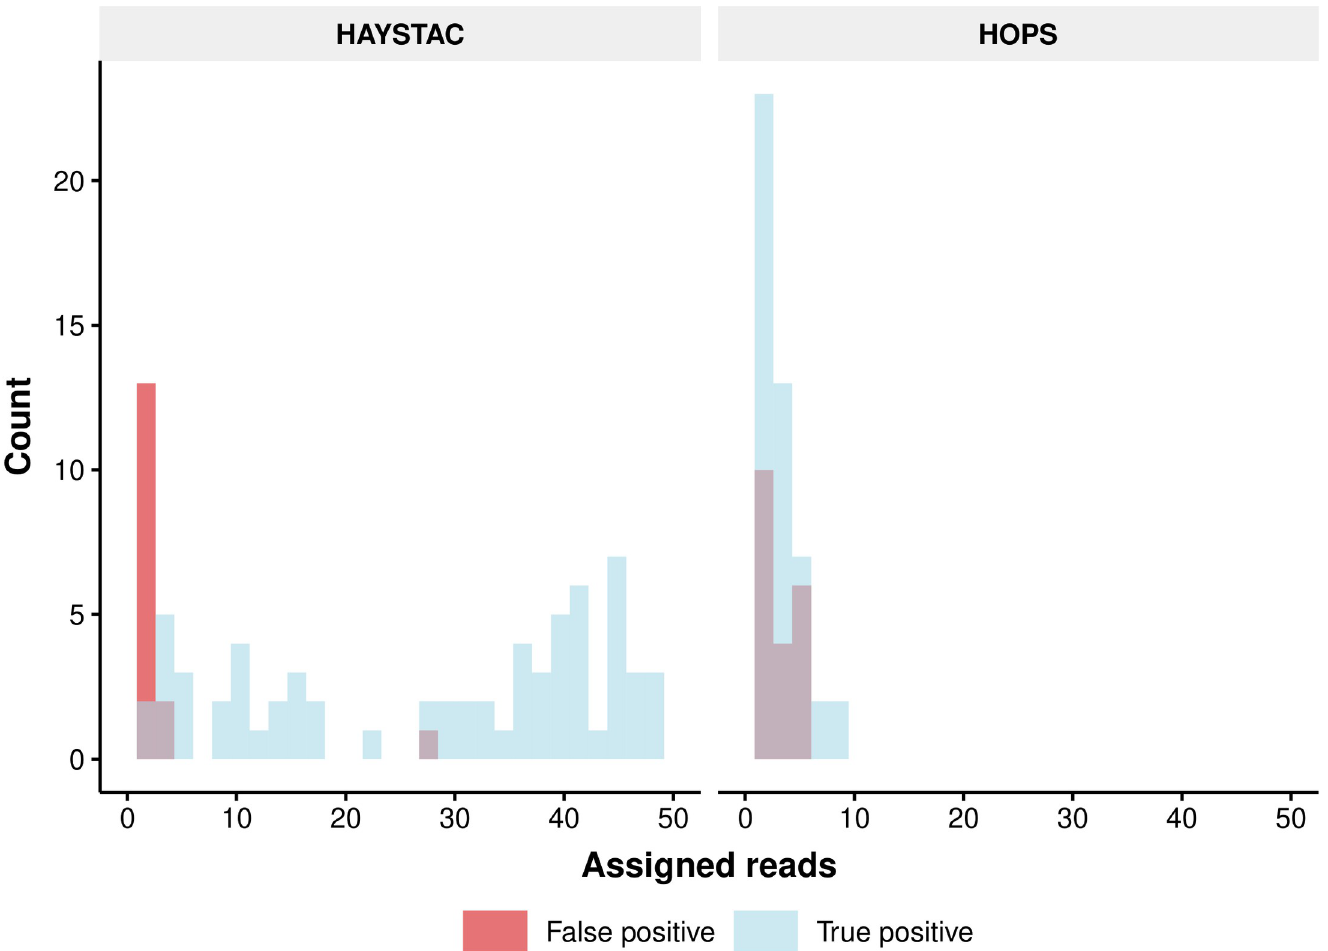
Fig 7. Histogram of the number of assigned pathobiont simulated reads. Histogram showing the read count frequency of true positive (blue) and false positive (red) pathobiont reads as identified by HAYSTAC and HOPS, after screening 200 spiked iterations of an ancient Oral Microbiome dataset sample (anc200e2repgn). HAYSTAC identifies robustly more pathobiont reads than HOPS, while producing less false positive identifications.